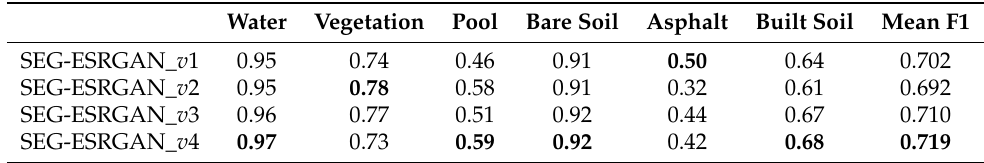
Analyzing Table A2, we notice that using the combination of RRDB-BN-scSE in each encoder block produced an increment of the performance in the minority class (the swim- ming pool) that motivated us to continue with this architecture. Table A2. Different versions of the SEG-ESRGAN model and the performance on each class using the F1 metric. Best values in